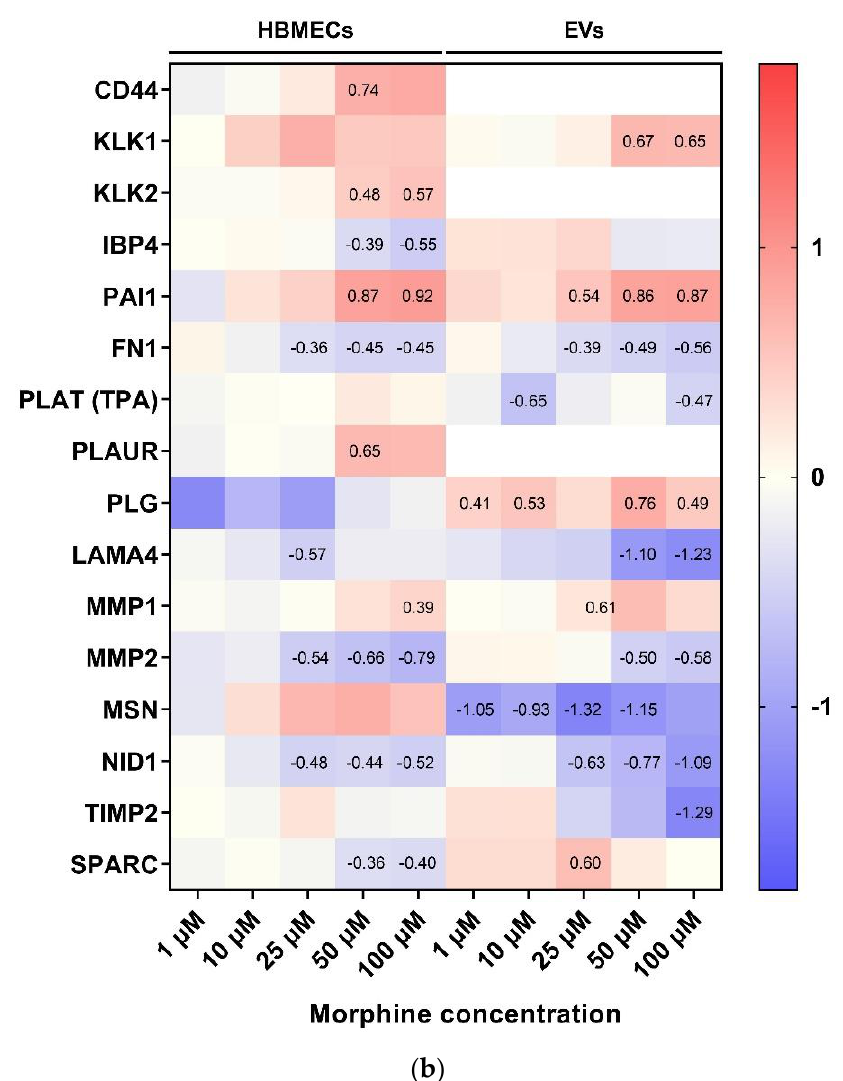
Figure 6. Cell adhesion and extracellular matrix remodeling pathway map with associated heatmap representation of morphine-treated human brain endothelial cells and extracellular vesicles. ( a ) Pathway map of cell adhesion and extracellular matrix remodeling. Modulated proteins upon morphine treatment of HBMECs and associated EVs are presented in grey circles. Red lines represent inhibition/negative interactions, green lines represent activation/positive interactions and grey lines represent unspecified interactions. ( b ) Heatmap displaying DEPs associated to cell adhesion and extracellular matrix remodeling pathway. Color scale corresponds to log ratio of proteins. White color corresponds to unquantified proteins. Numbers in squares are log ratio of DEPs. HBMECs = human brain microvascular endothelial cells, EVs = extracellular vesicles.